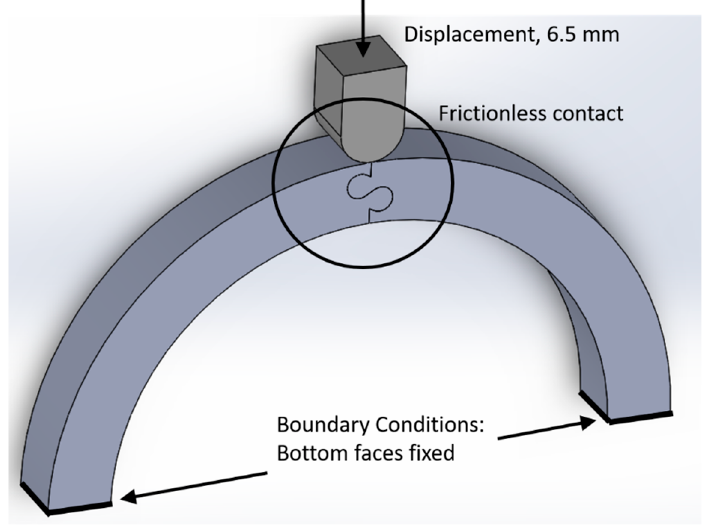
Figure 5. FEM setup: indenter displaces 6.5 mm, the bottom archway faces are fixed, and the three contacting surface pairs are modeled with frictionless contact.